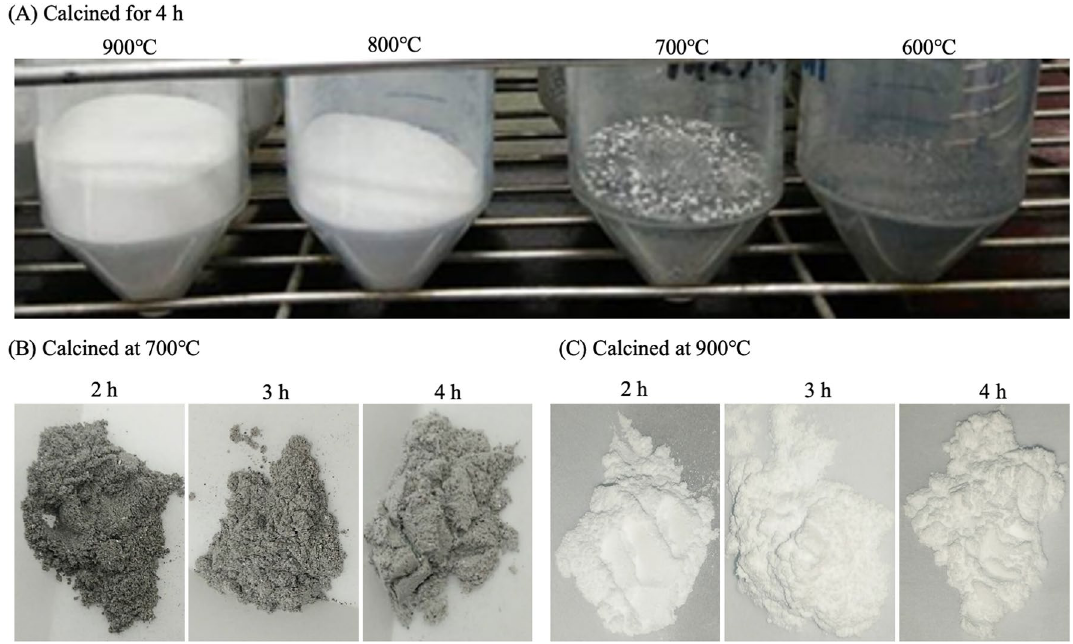
Figure 3. The appearance of eggshells that were calcined under different conditions. ( A ) Calcined for 4 h at different temperatures; ( B ) calcined for 2–4 h at 700 °C; and ( C ) calcined for 2–4 h at 900